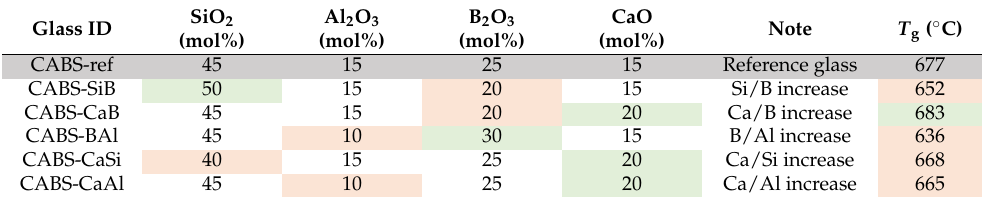
Table 1. Nominal chemical compositions of the CABS glasses as well as their measured glass transition temperature ( T g ). Coloring indicates reference content or T g (grey), increasing content or T g relative to reference (green), and decreasing content or T g relative to reference (red). The error in T g was within ± 2 ◦